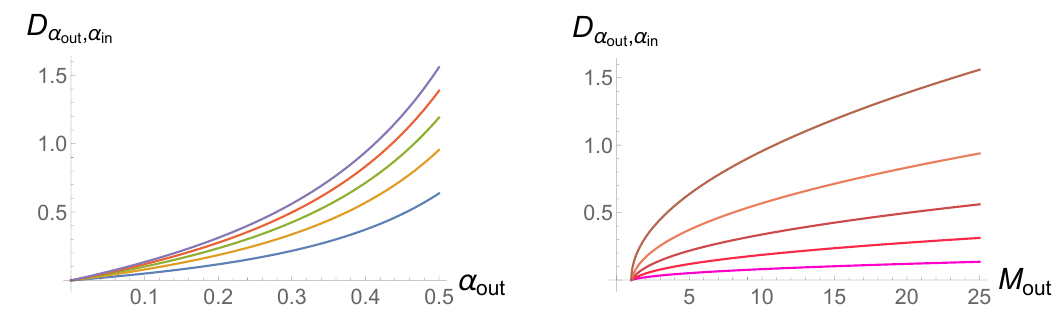
Figure 17 . (Left) D (cid:11) for M in = 1 ; M out = 5 ; 10 ; 15 ; 20 ; 25 from the bottom-up. (Right) out ;(cid:11) in D (cid:11) as a function of M out for M in = 1 and (cid:11) out = 0 : 1 ; 0 : 2 ; 0 : 3 ; 0 : 4 ; 0 : 5 from the bottom-up. out ;(cid:11) in We rescaled the prefactor c= 3.